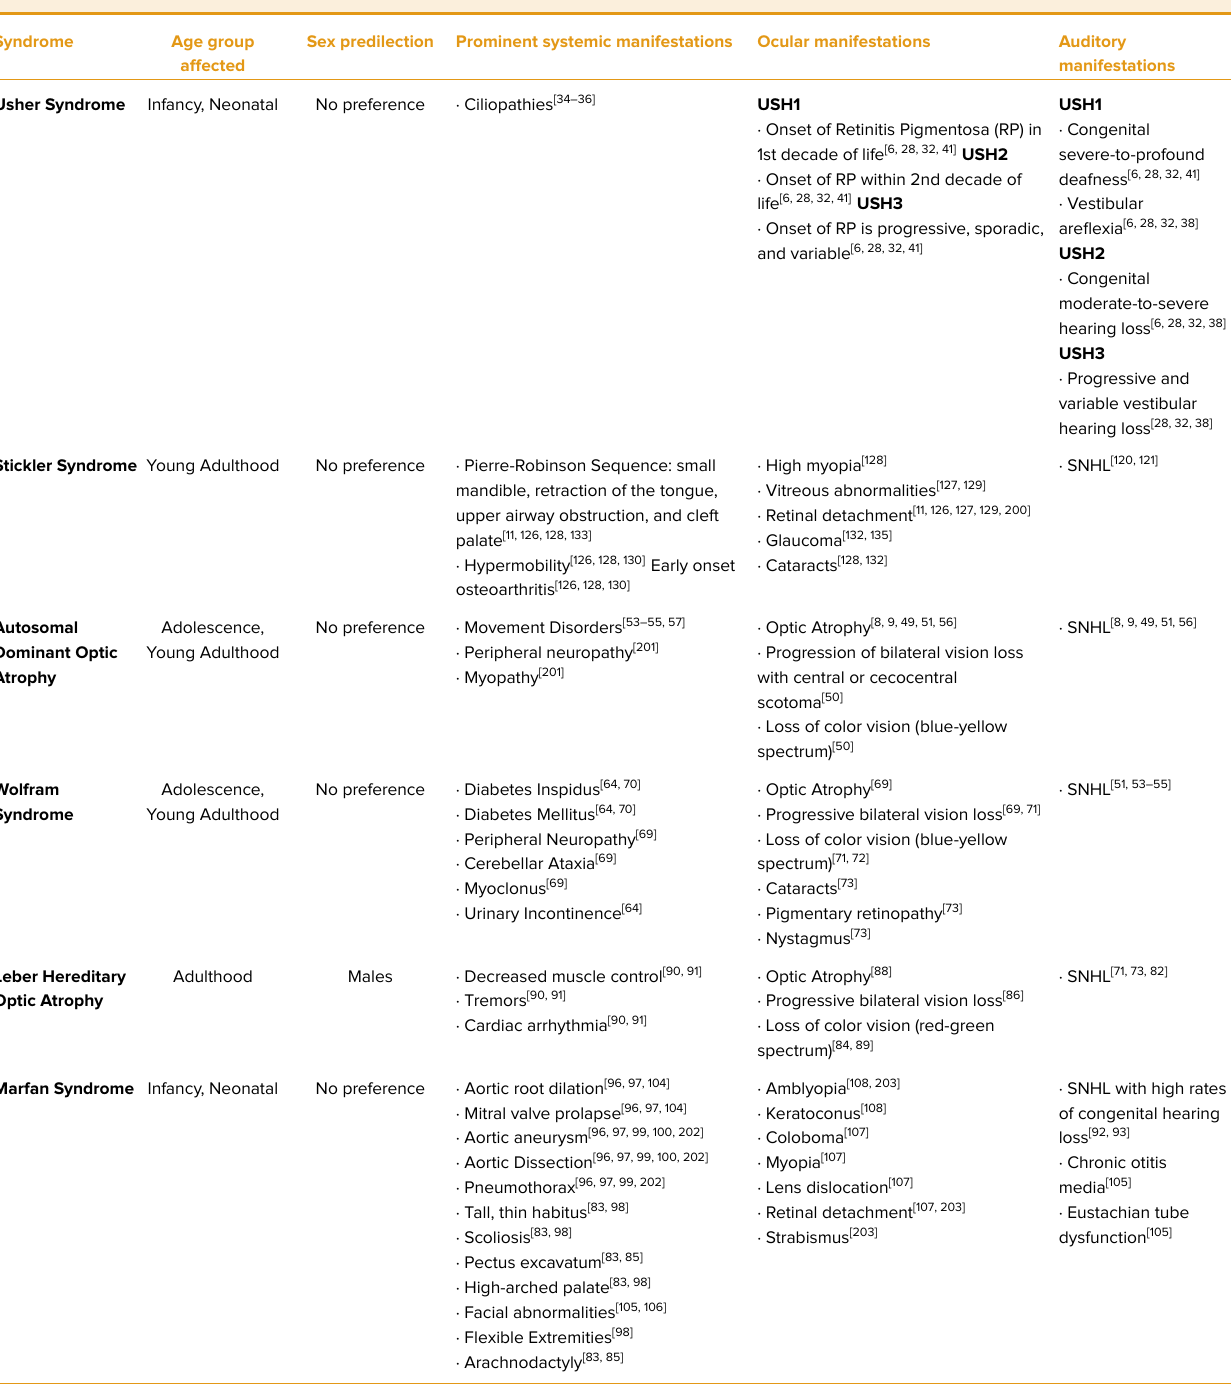
Table 1. Summary of syndromes that include both ocular and sensorineural hearing loss